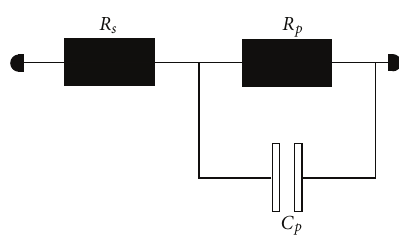
Figure 8: Equivalent circuit model of